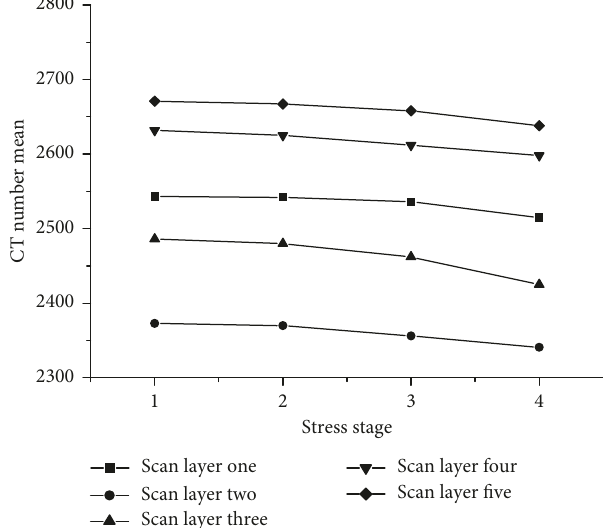
Figure 17: The curves of CTnumbers for the four stress stages for specimen CON080.